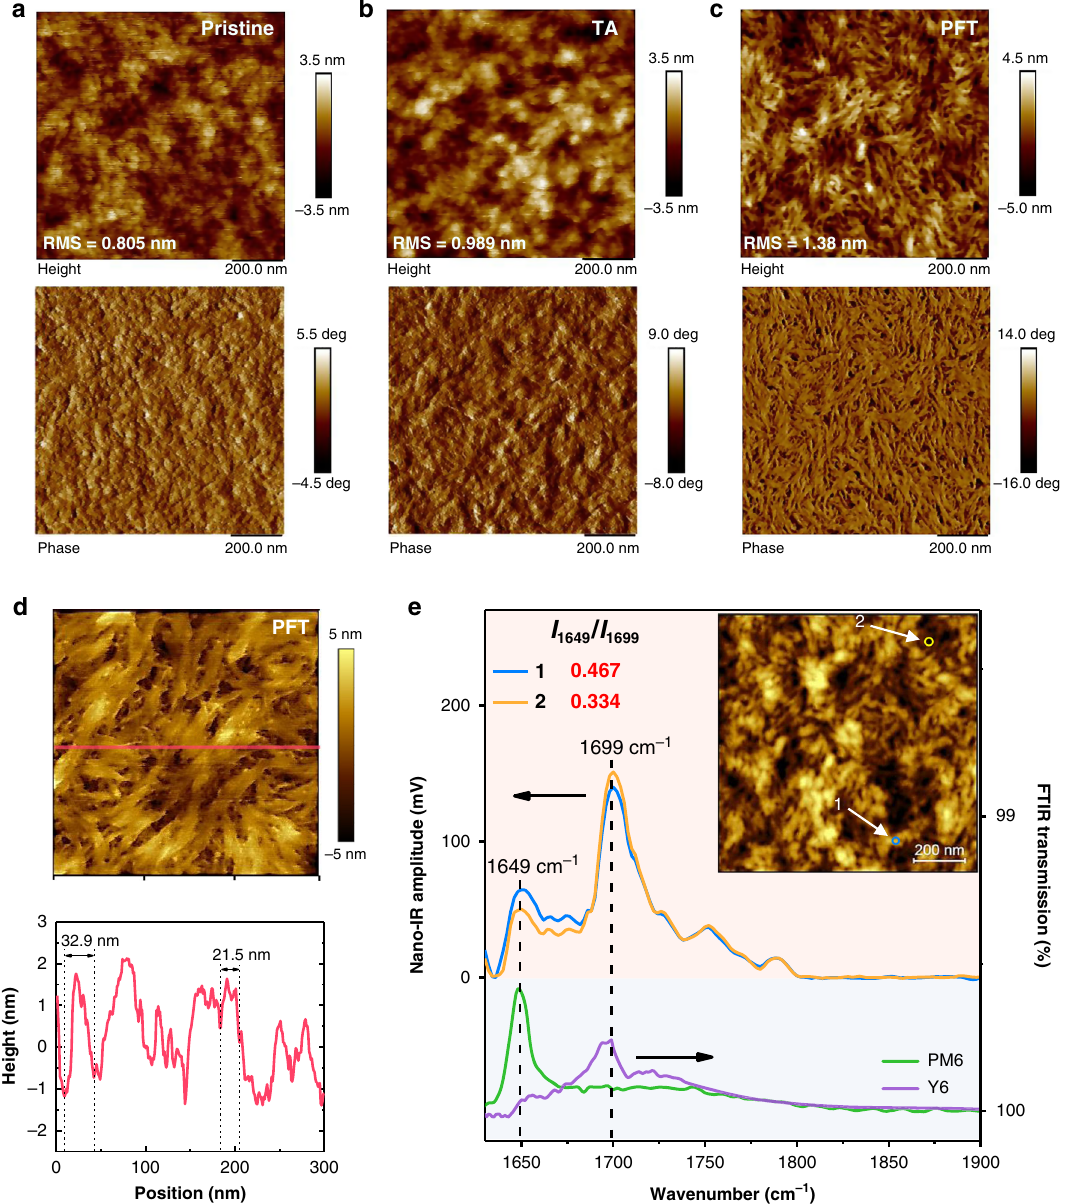
Fig. 4 Morphology investigations. a – c AFM height (top) and phase (down) images of a pristine, b TA and c PFT-treated fi lms. d AFM zoom-in image with high resolution (top) and height difference curve (down) of cutting line. e AFM topography image of PFT-treated fi lms (top right) and corresponding Nano- IR spectra from the color-cycled positions (top), together with FTIR spectra of PM6 and Y6